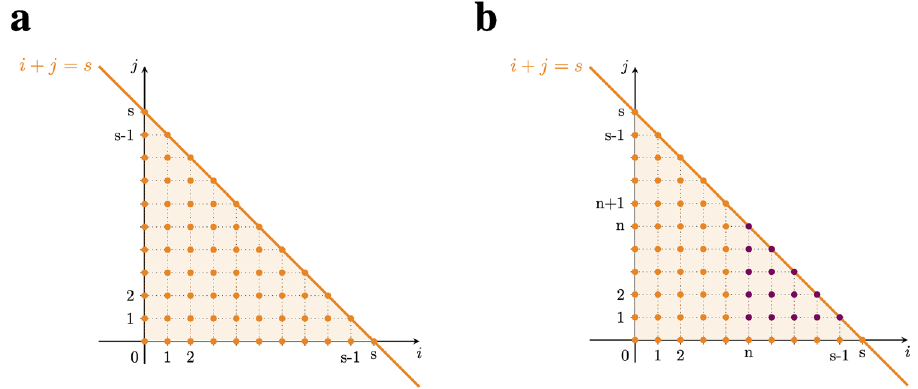
Figure 3. Insights on the algorithmic complexity. For rational values of p = 1 n + 1 and p = n n + 1 , with integer n , the possible state values J s at level s are k = i − nj , with i and j respectively the number of times the positive and negative reward is observed, such that i , j ≥ 0 and i + j ≤ s . For different values of i and j within the allowed set, k can have repeated values leading to degenerate states. ( a ) Possible ( i , j ) pairs for admissible states at level s . ( b ) Same as in (a); in purple, the pairs leading to an already considered state (overlapping states). A